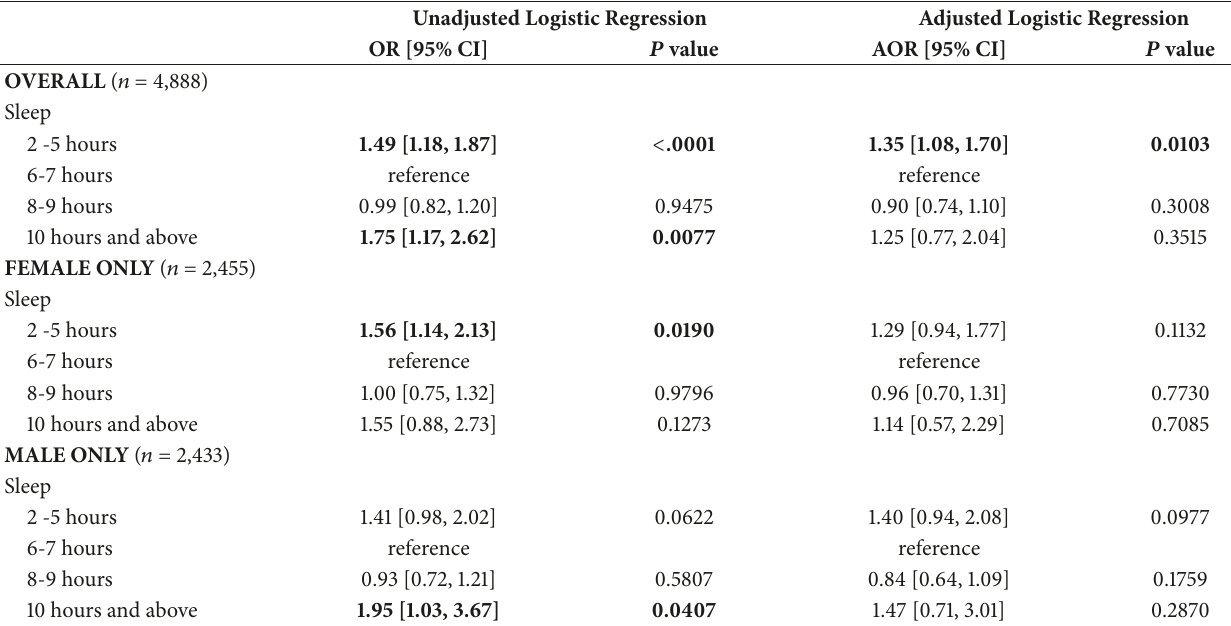
Table 2: Odds ratios (ORs), adjusted odds ratios (AORs), and 95% confidence intervals (CIs) of sleep from logistic regression on self-reported diagnosis of arthritis National Health and Nutrition Examination Survey, 2009-2012,